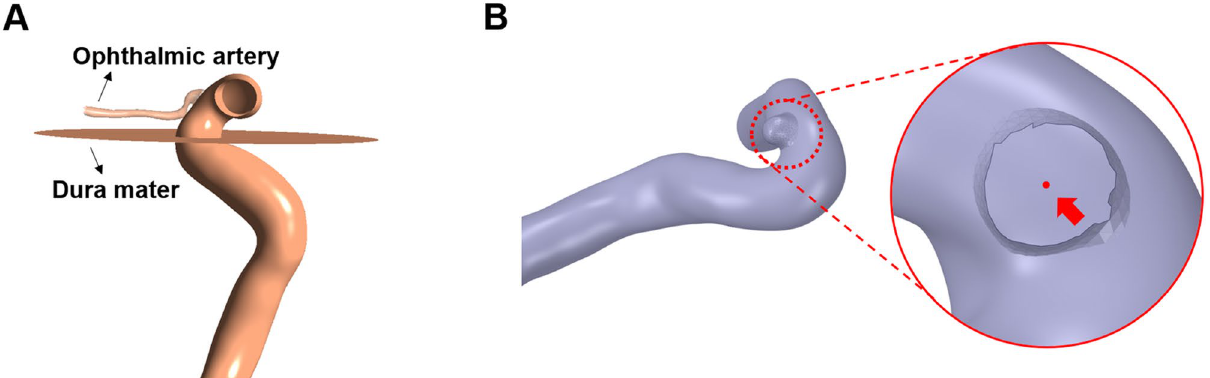
Figure 2. The methods determining the locations of the dura mater and the aneurysm formation site. The location of the dura mater was assumed below the position of the ophthalmic artery ( A ). In addition, the center of the aneurysm orifice center (red arrow) was assumed to be the location of the aneurysm formation site ( B